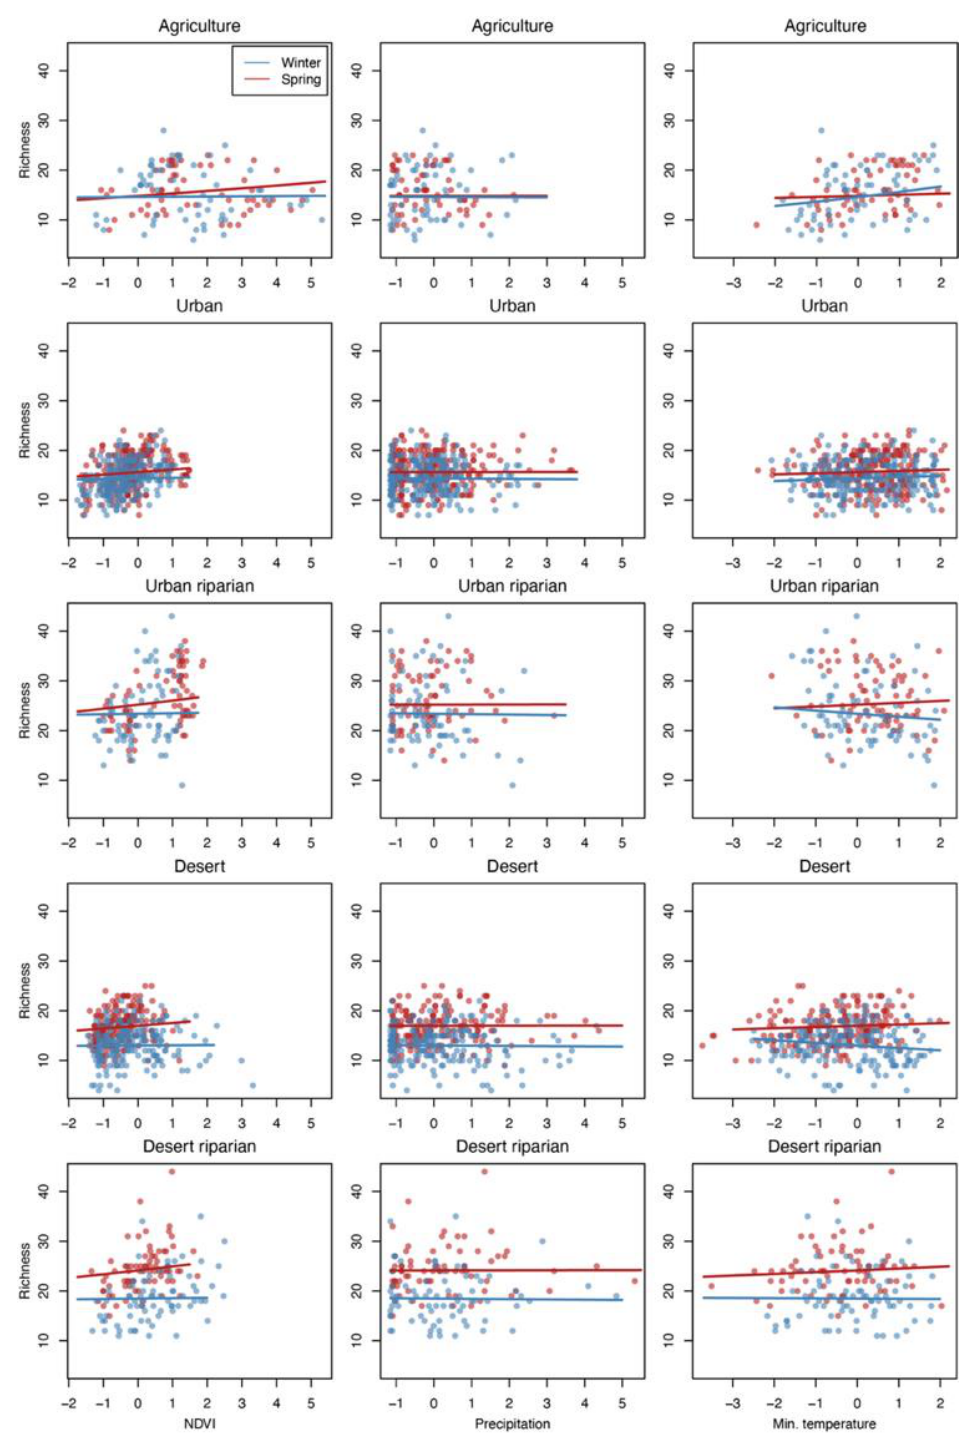
Figure 4. Scatterplots of avian richness and environmental variables: NDVI (left column), precipitation (middle column), and minimum temperature (right column). Graphics are organized by land-use type (rows). Lines represent the fit of the averaged generalized linear mixed models for avian abundance in spring (red) and winter (blue).